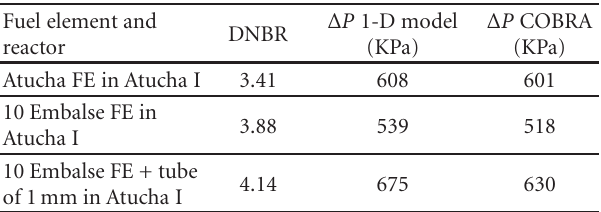
Table 6: Thermohydraulic margin and pressure drop model com-